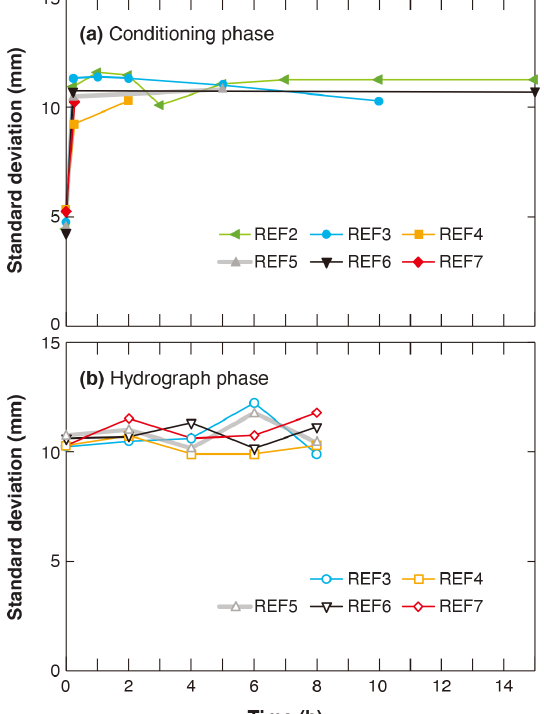
Figure 4. Temporal adjustments of standard deviation of bed ele- vation calculated over the whole erodible bed: (a) the conditioning phase and (b) the hydrograph phase. The uncertainty of the calcu- lation is in the range of 1.6–2.5mm, which is close to the vertical resolution of the laser (1mm).